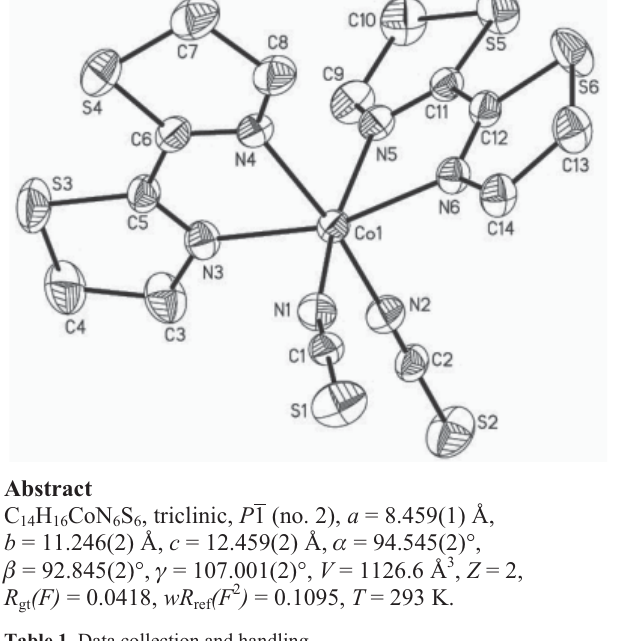
Table 1. Data collection and handling.